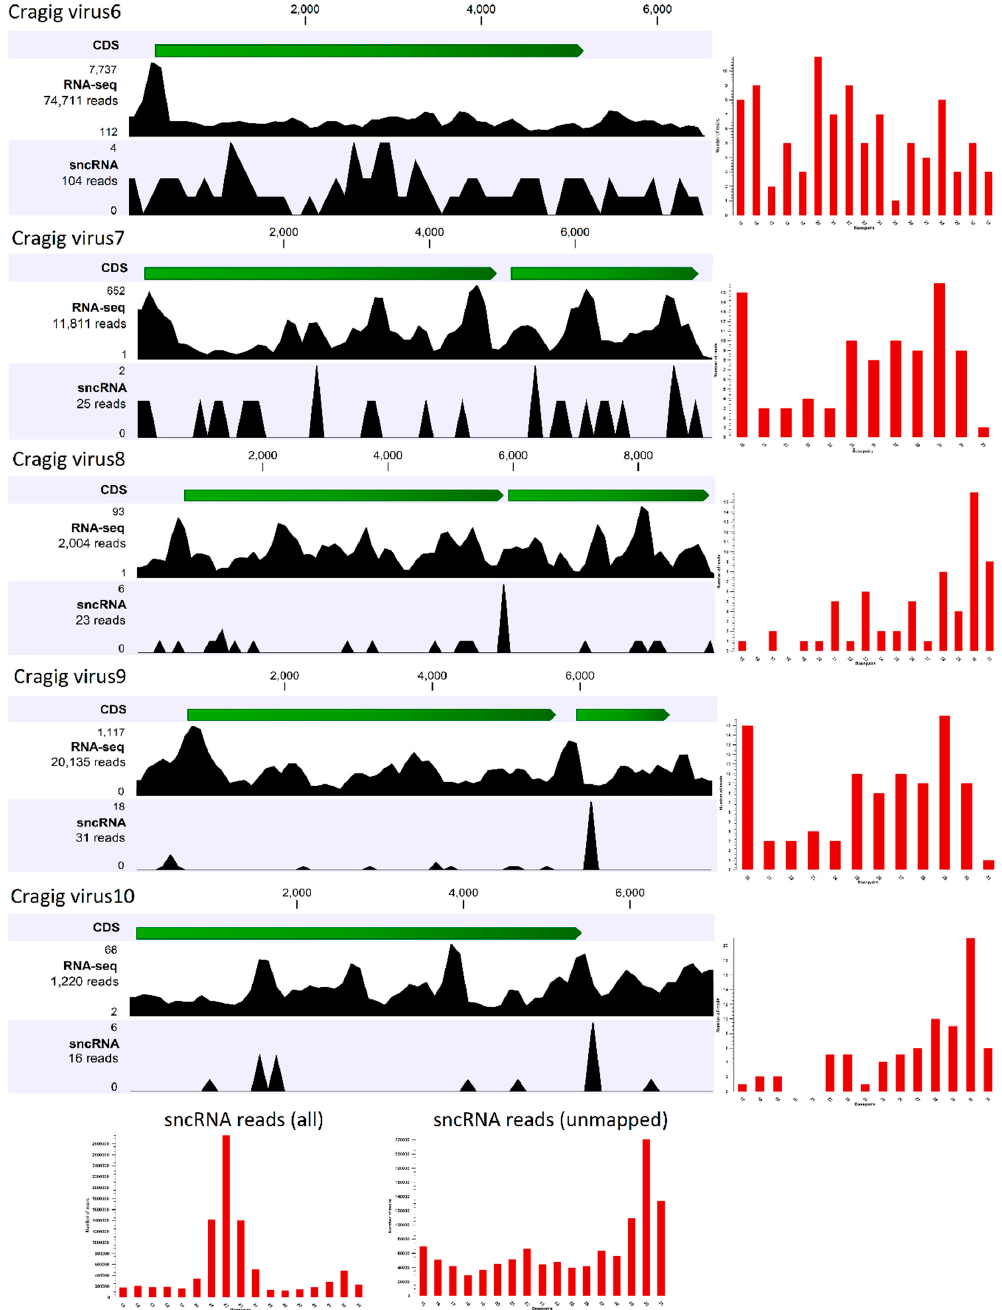
Figure 3. Small non-coding RNA (sncRNA) reads analysis. The RNA-seq and sncRNA read distribution for each of the five “nearly complete viral genomes” reconstructed from the ribo-depleted oyster RNA-seq data are shown. The open reading frames (ORFs) for each virus are shown in green, while the number of mapped reads are reported on the left. The histograms on the right represent the size distributions of the mapped sncRNA reads (in the range of 15–31 nt). The bottom histograms show the size distribution for the whole library (left), and for the reads that did not match the oyster genome (right).